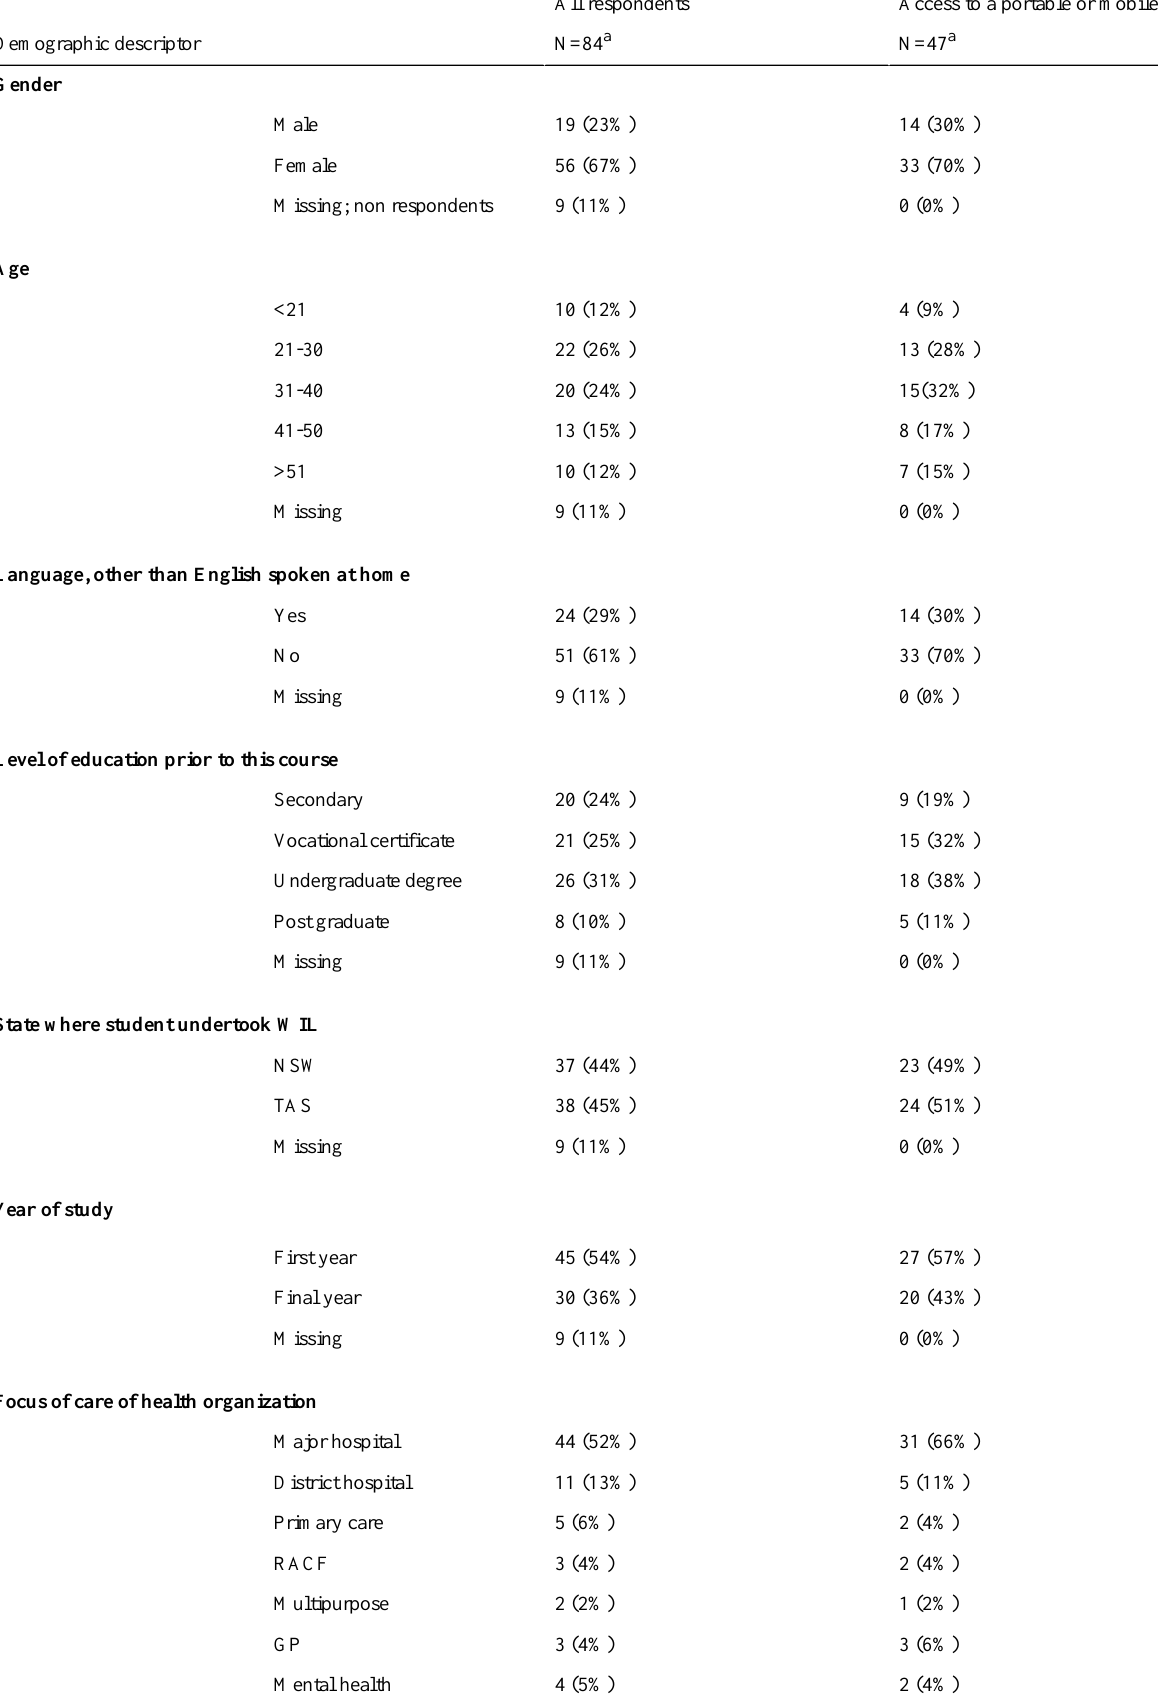
Table 1. Demographic information of respondent access to a mobile or portable